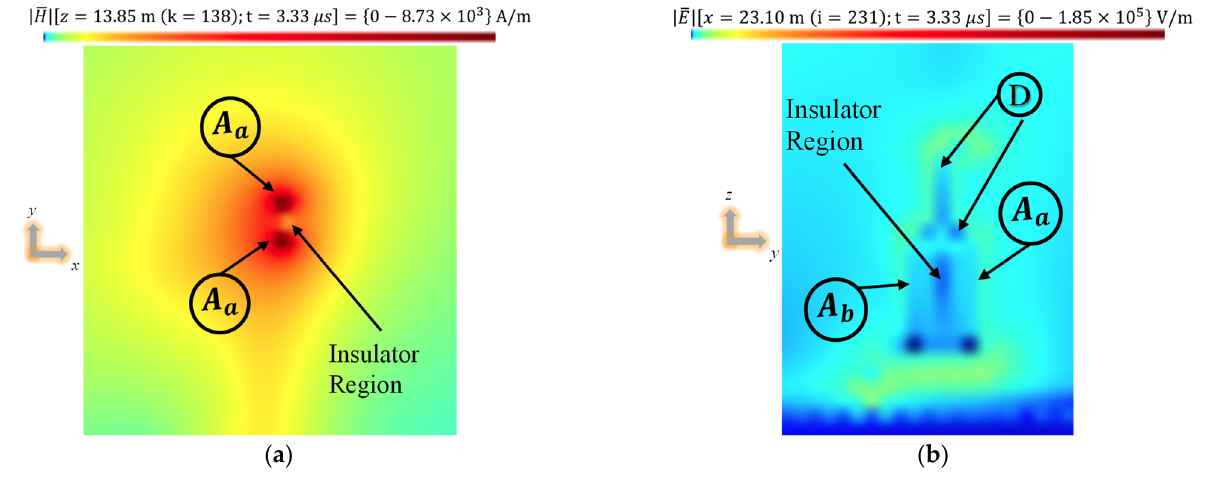
Figure 13. Spatial distributions of |𝐻(cid:3365)| and |𝐸(cid:3364)| calculated using the FDTD method for PC6: (a) |𝐻(cid:3365)|(𝑧 = 13.85 m,𝑡 = 3.33 μs) and (b) |𝐸(cid:3364)|(𝑥 = 23.10 m, 𝑡 = 3.33 μs) .